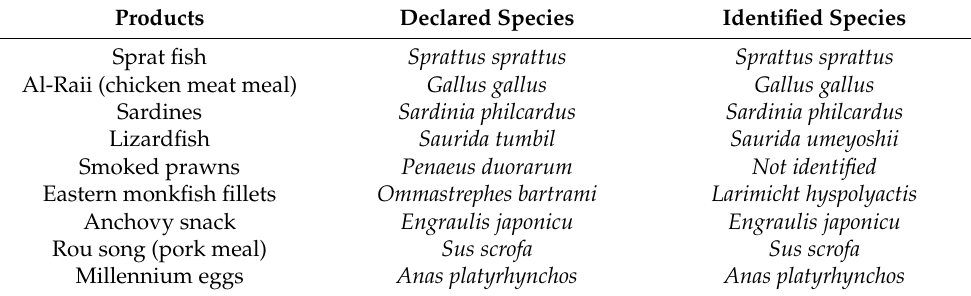
Table 8. Multiplex PCR of meat- and fish-based